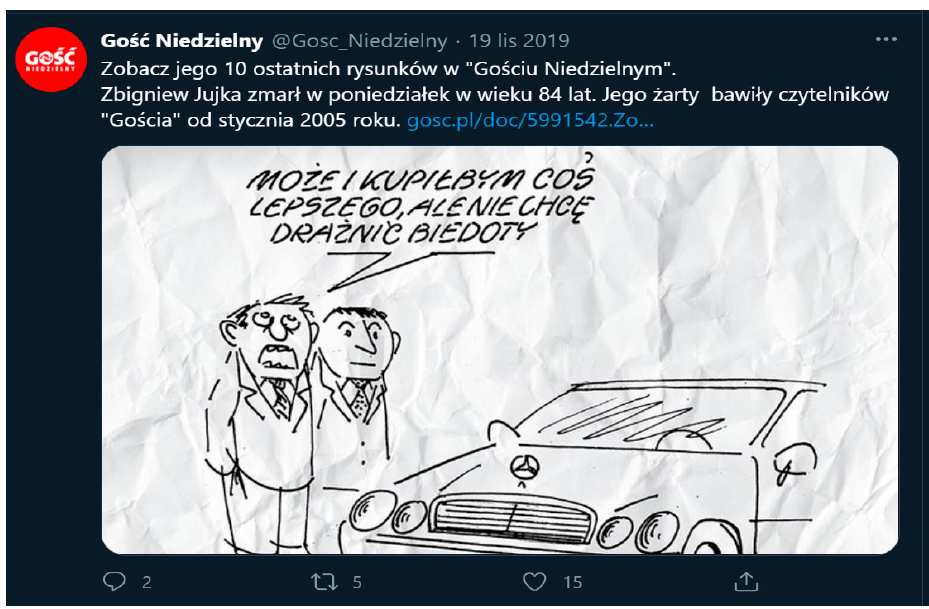
Figure 4. A self-promotional tweet by Go ść Niedzielny , 19.11.2019. Source: Twitter/screenshot.